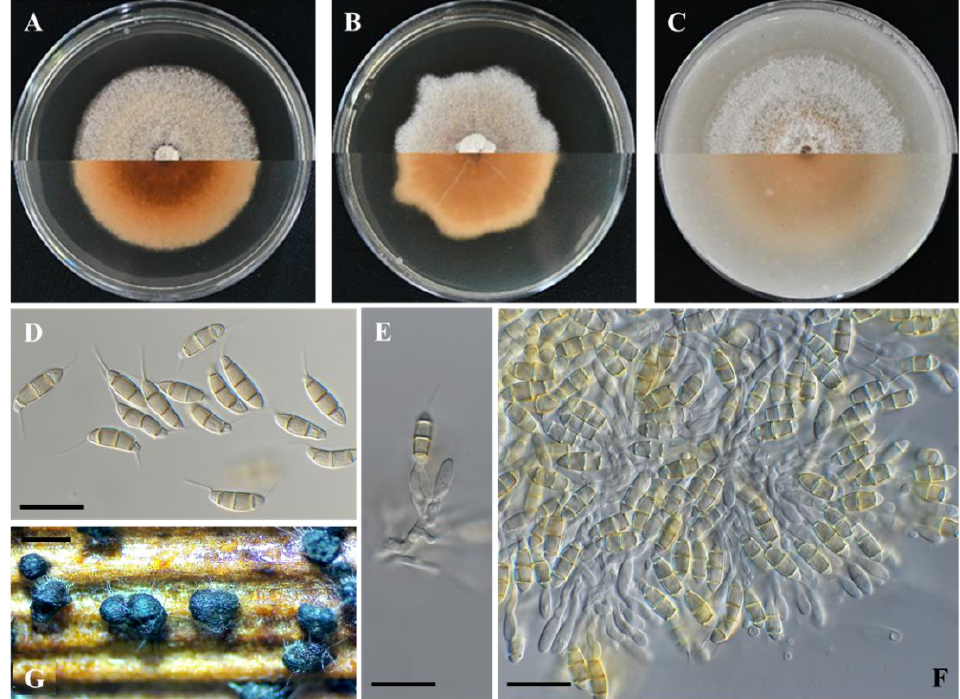
Figure 4. Seimatosporium vitis-viniferae isolate P60 (CBS 149016). ( A – C ) Colonies cultured on PDA, MEA, and OA, respectively, at 25 °C in the dark for 14 days (top: above and bottom: reverse). ( D ) Septate conidia with basal and apical appendages. ( E , F ) Septate conidiophores, conidiogenous cells and conidia. ( G ) Conidiomata on autoclaved grapevine wood segments. Scale bars: 20 µ m ( D – F ) and 500 μm ( G ).